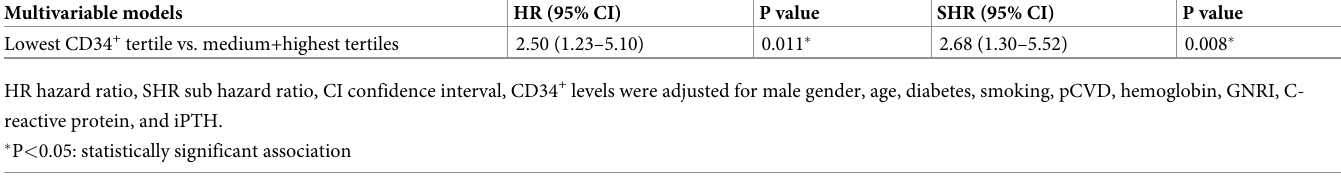
Table 5. Hazard and Sub-hazard ratio of CVD-death in the lowest tertile of relative CD34 + cells by Cox regression and competing regression analysis. Multivariable models Lowest CD34 + tertile vs. medium+highest